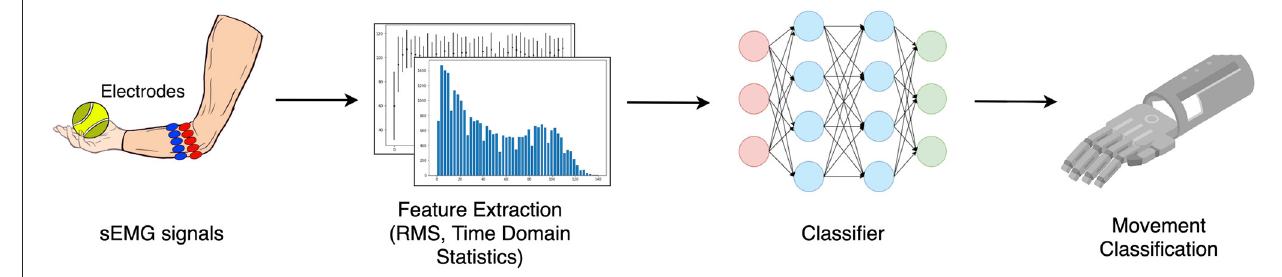
FIGURE 1 | Overview of hand movement classification using sEMG.